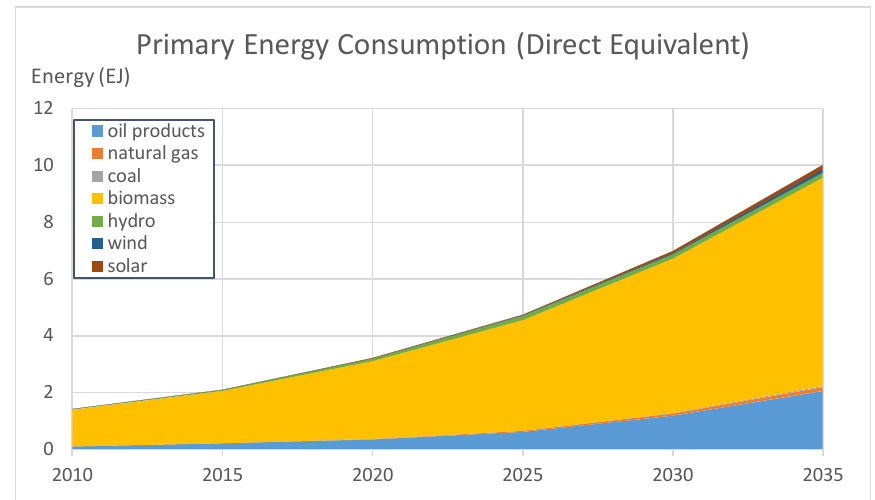
Figure 4. Primary Energy Demand for Reference Case (Unit: EJ).